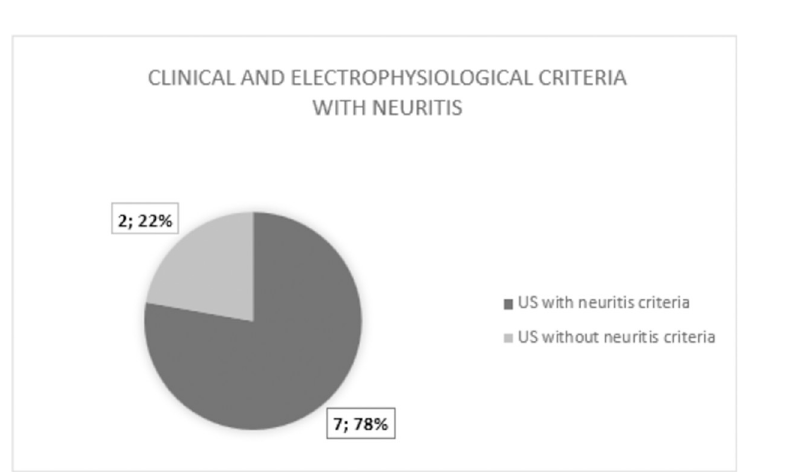
Fig 3. Comparison of patients classified as having neuritis by clinical and electrophysiological criteria (reference criteria) with the ultrasound classification.